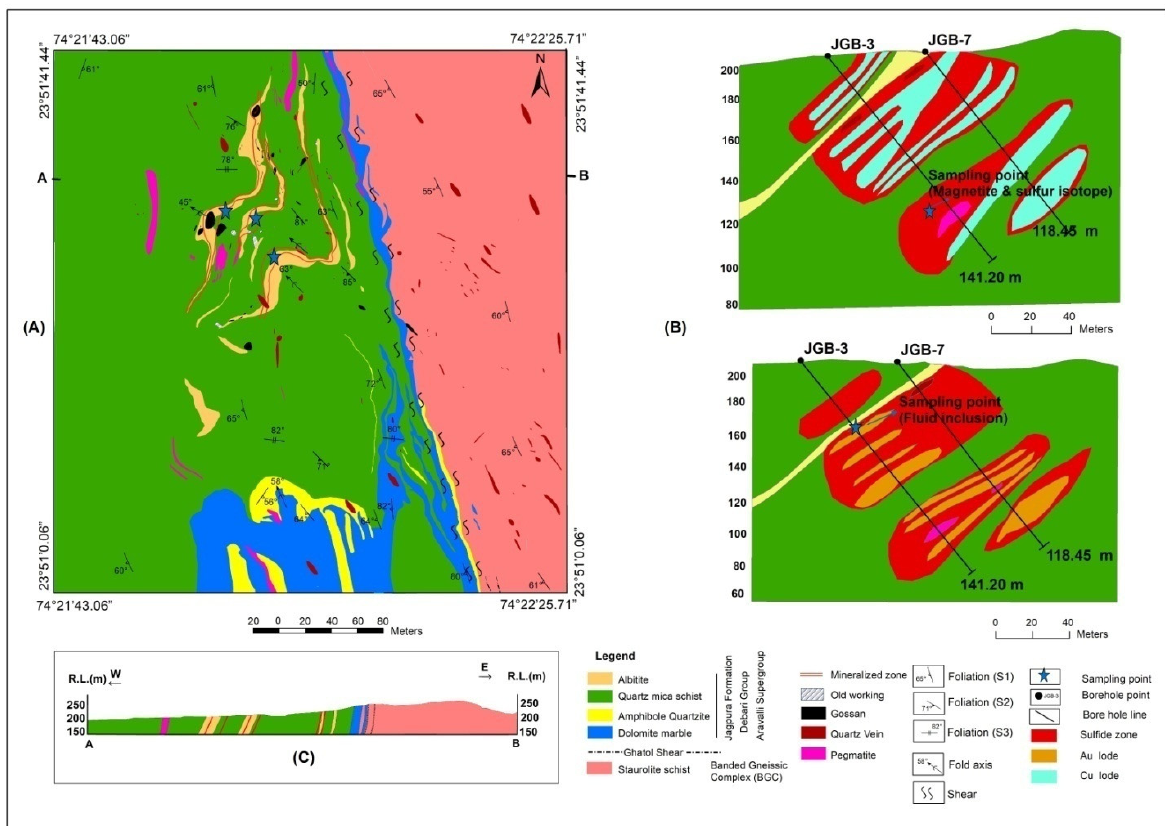
Figure 3. ( A ) Geological map of the Jagpura deposit showing different litho-units and mineralized zones, modified from reference [57], Albitite is from reference [27]; ( B ) longitudinal borehole cross- section showing the position of ore lodes; ( C ) Geological cross-section along line A–B in Figure 3A. Staurolite schist is asilver-grey to dark grey colored fine to medium grained rock. The contact between staurolite schist and dolomitic marble is sheared, marked by various kine- matic indicators in which sigma structure of quartz porphyroblast indicates a dextral sense of shearing. Dolomitic marble is medium to coarse-grained, fawn colored crystalline